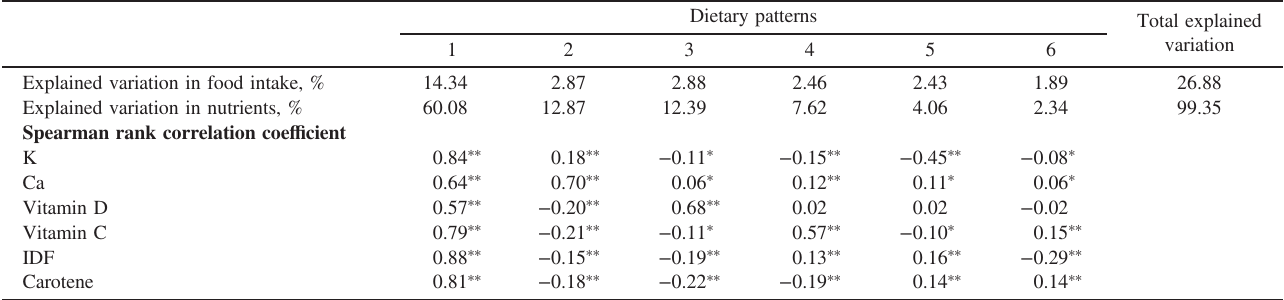
Table 1. Explained variations in nutrients and food intake and Spearman rank correlation between nutrients (response variables) and RRR-derived dietary